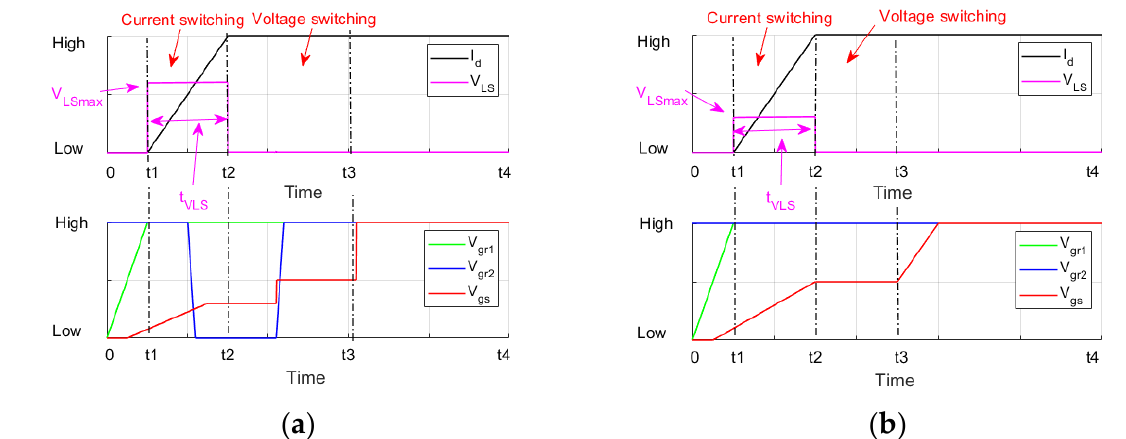
Figure 13. Simulated signals of the proposed circuit: ( a ) case 1, ( b ) case 2.